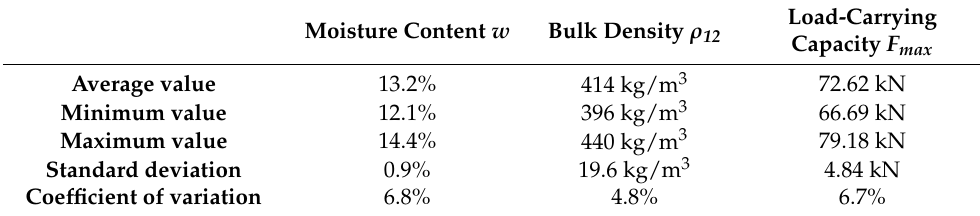
Table 7. Results of the experimental testing of H3 specimens.